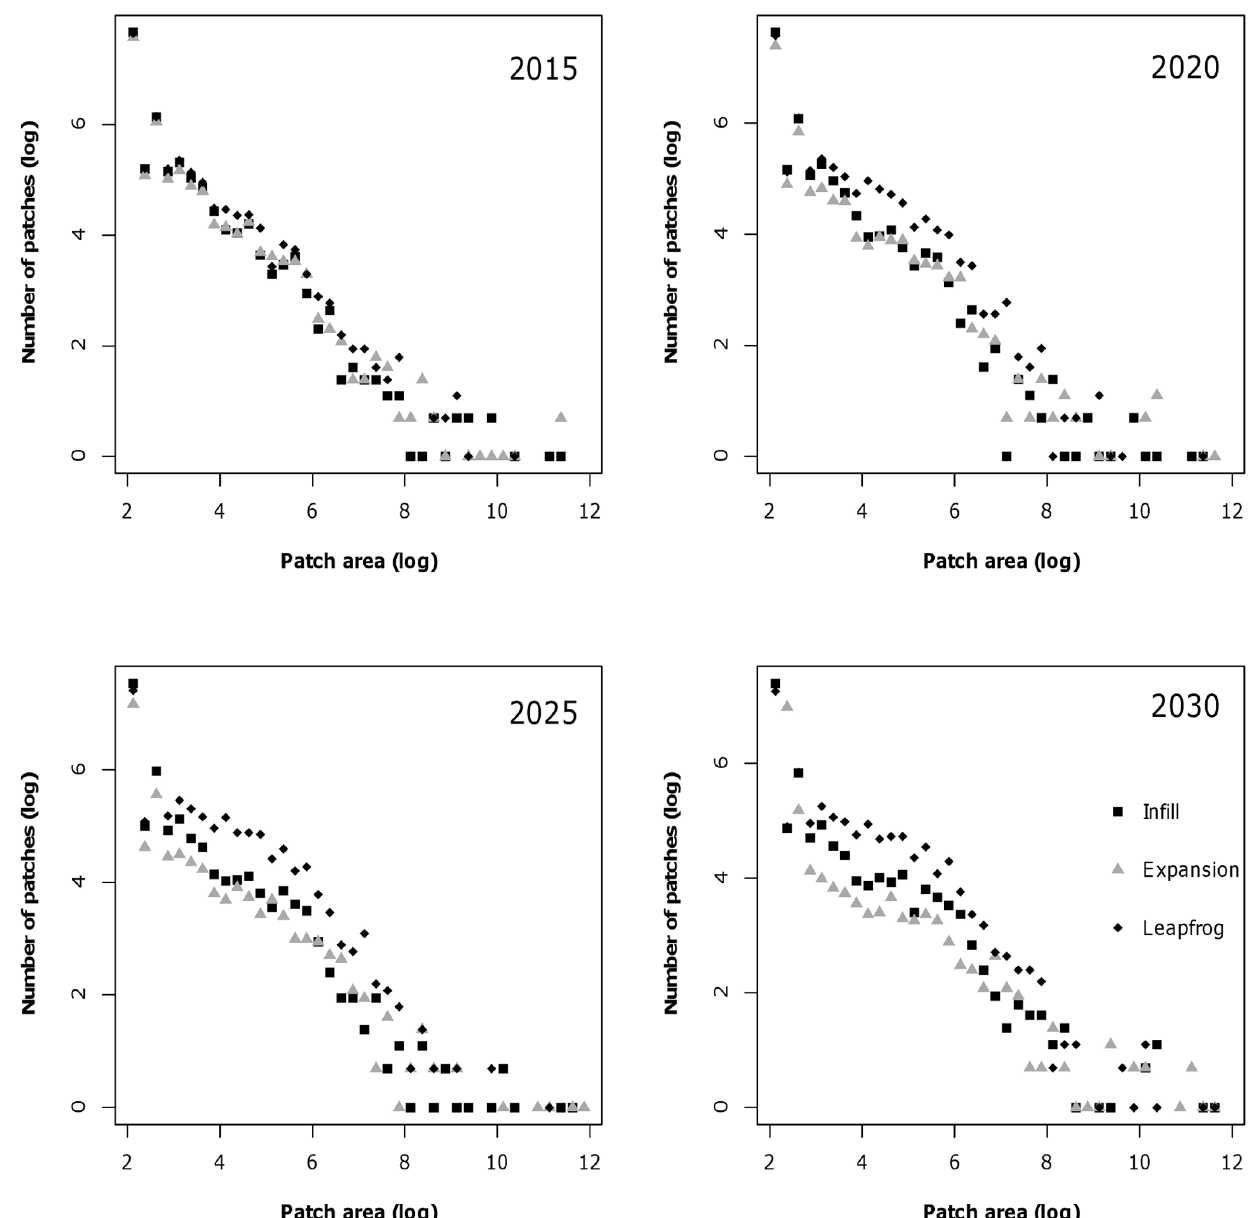
Figure 2. Trends in number of patches and patch area for three planning policy simulations from 2010–2030. Numbers were log- transformed for better visual representation of the